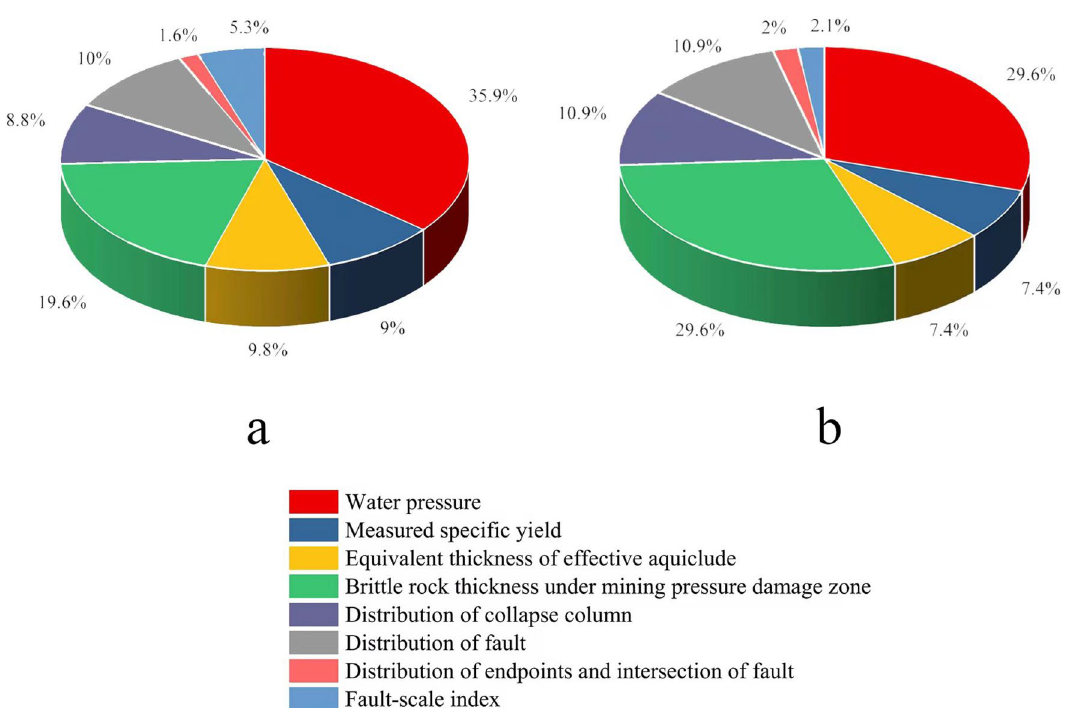
Figure 3. Pie chart of influence factor weights: ( a ) Ordovician limestone aquifer, ( b ) Benxi limestone